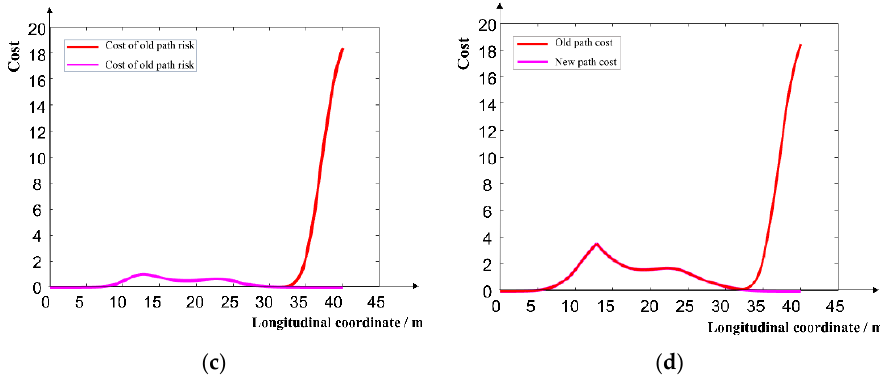
Figure 17. Comparison of new and traditional paths in the actual vehicle scenario: ( a ) cost of smoothness of path; ( b ) cost of lateral offset from road centerline; ( c ) path risk cost; ( d ) path cost.